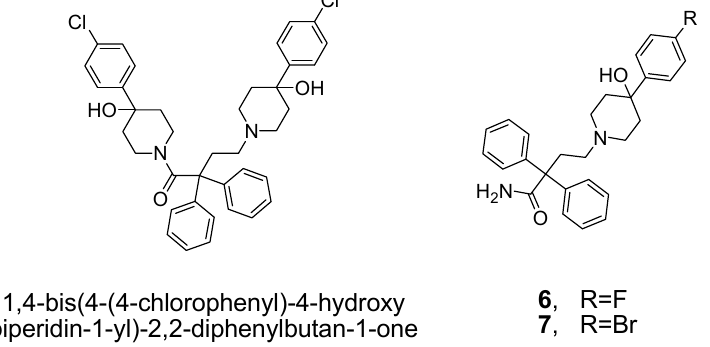
Figure 2. Structures of novel loperamide